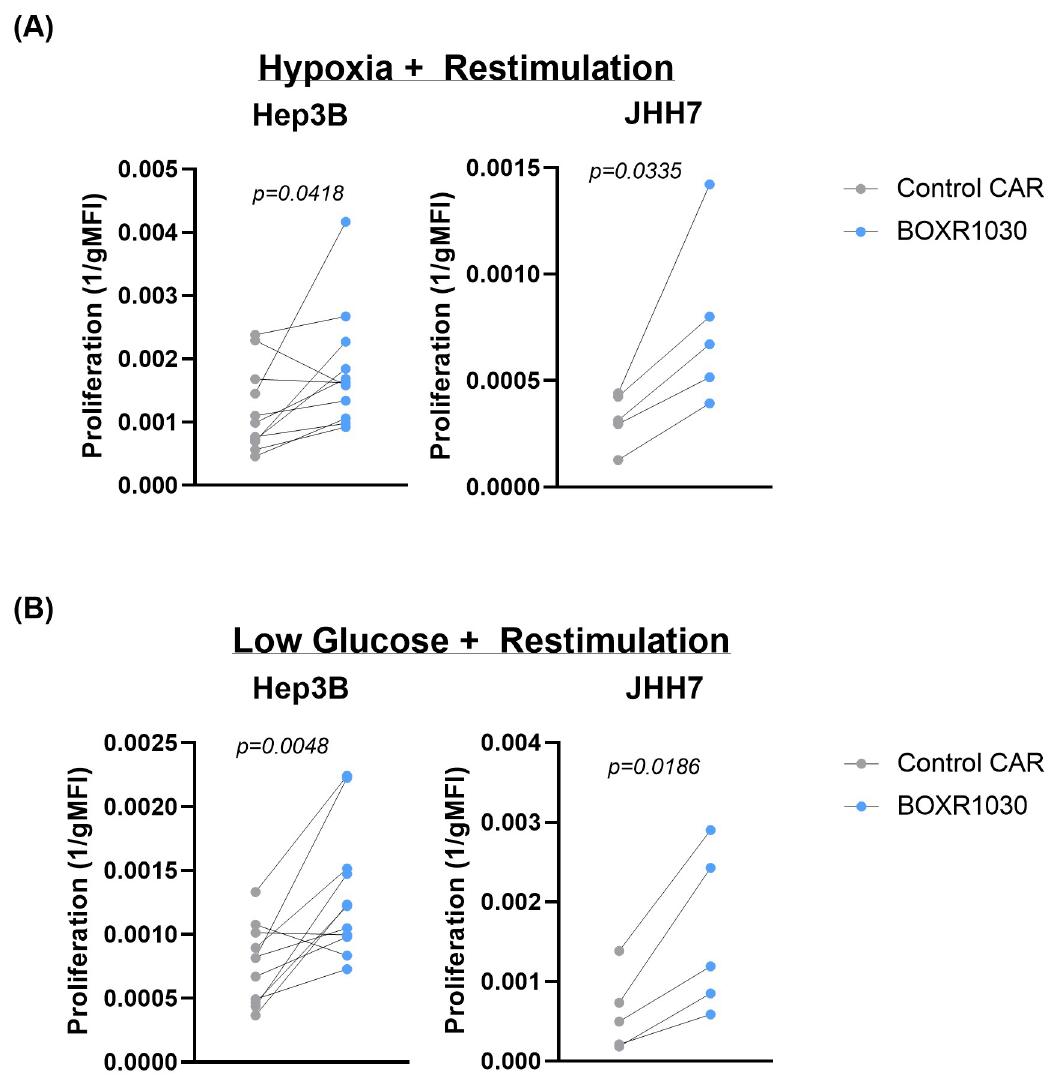
Fig 5. In vitro activity of BOXR1030 under conditions simulating the solid tumor microenvironment. BOXR1030 or control CAR T cells were repeat stimulated with GPC3+ target cell lines on day 0 and on day 3 in hypoxic conditions (A) or low glucose conditions (B). (A and B) The gMFI of CellTrace Violet (CTV) was measured for BOXR1030 and control CAR stimulated with target cells on day 7 in the indicated culture conditions and proliferation was plotted as 1/gMFI. (n = 5 for JHH7 stimulated conditions and n = 11 for Hep3B stimulated conditions, statistical analysis was performed using a 2-tailed paired t-test, and p- values < 0.05 were considered statistically significant).